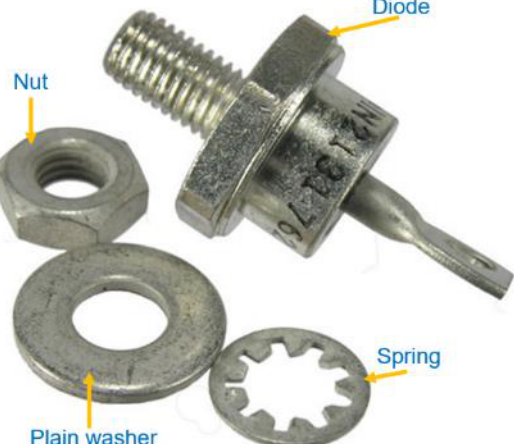
Figure 1: Commercially available 1N2131 200V 60A cathode stud system, similar to the presently investigated